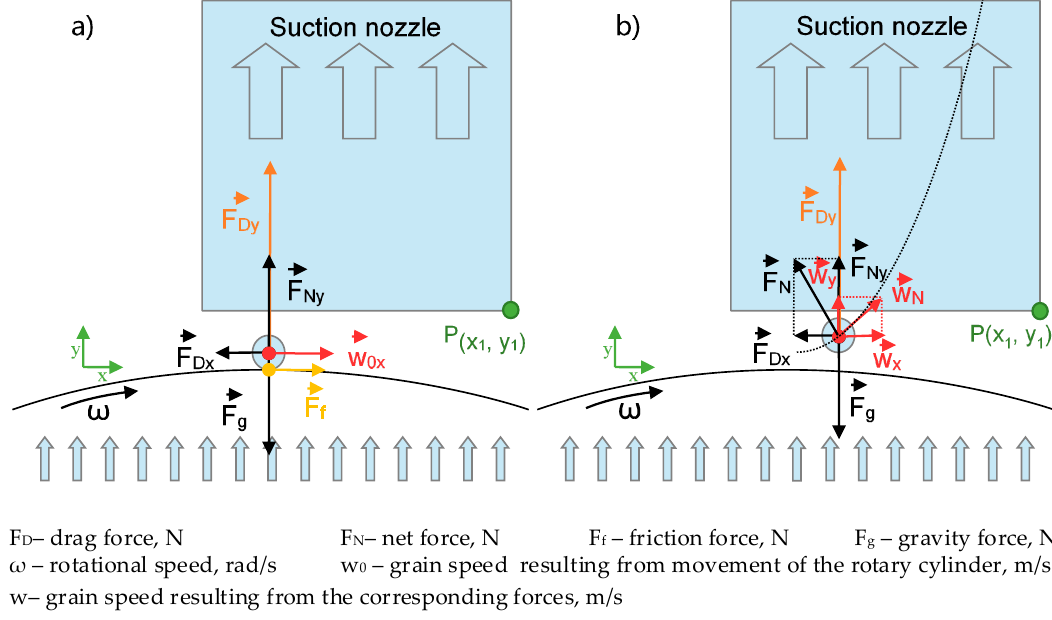
Figure 4. Forces acting upon the grain in the suction zone: ( a ) before suction and ( b ) during suction.